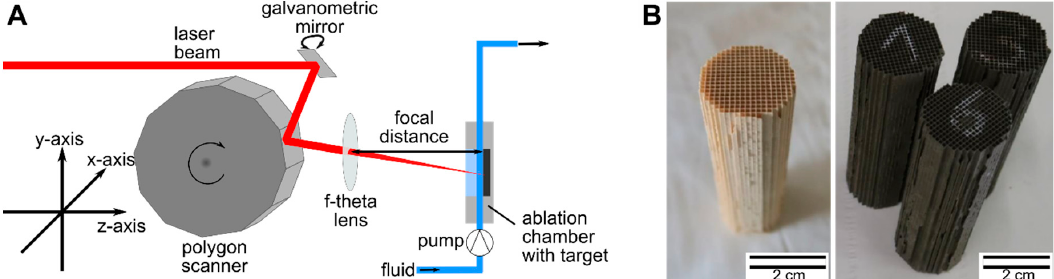
Figure 1. ( A ) Experimental setup of the laser-based continuous synthesis of colloidal nanoparticles (NPs); the laser beam is moved by a galvanometric mirror (slow axis), with supersonic lateral speed by a polygon scanner (fast axis) and focused by an f-theta lens on the metal target placed in the flow chamber. ( B ) Blank (left) and wash-coated (right) cordierite carriers with 3 wt.% laser-generated PtPd NP/Al 2 O 3 catalysts.